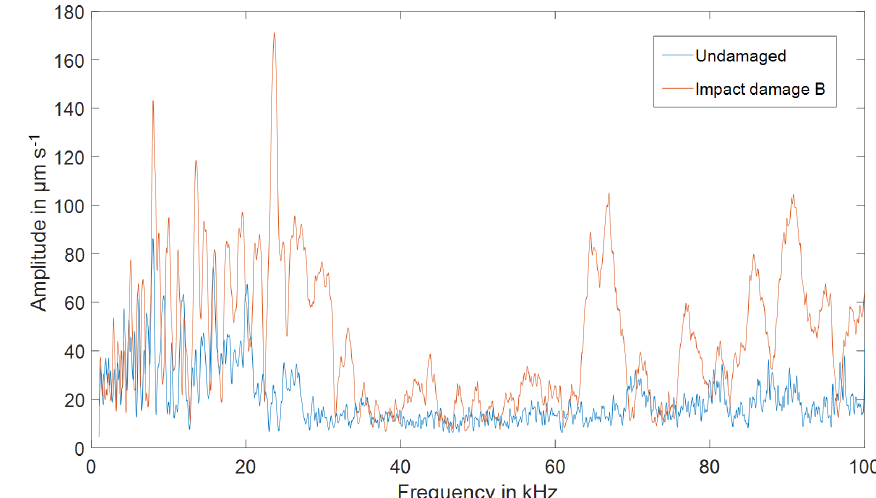
Figure 7. Vibration amplitude of impact damage B and undamaged CFRP car roof.